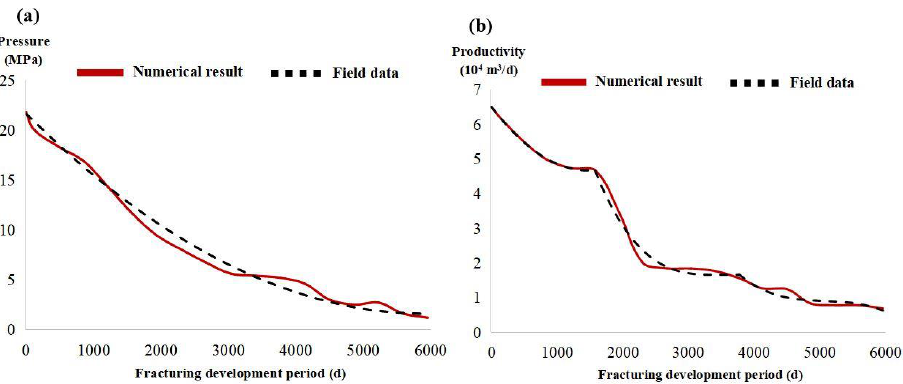
Figure 7. Verification of the numerical model with the field data. ( a ) From development pressure